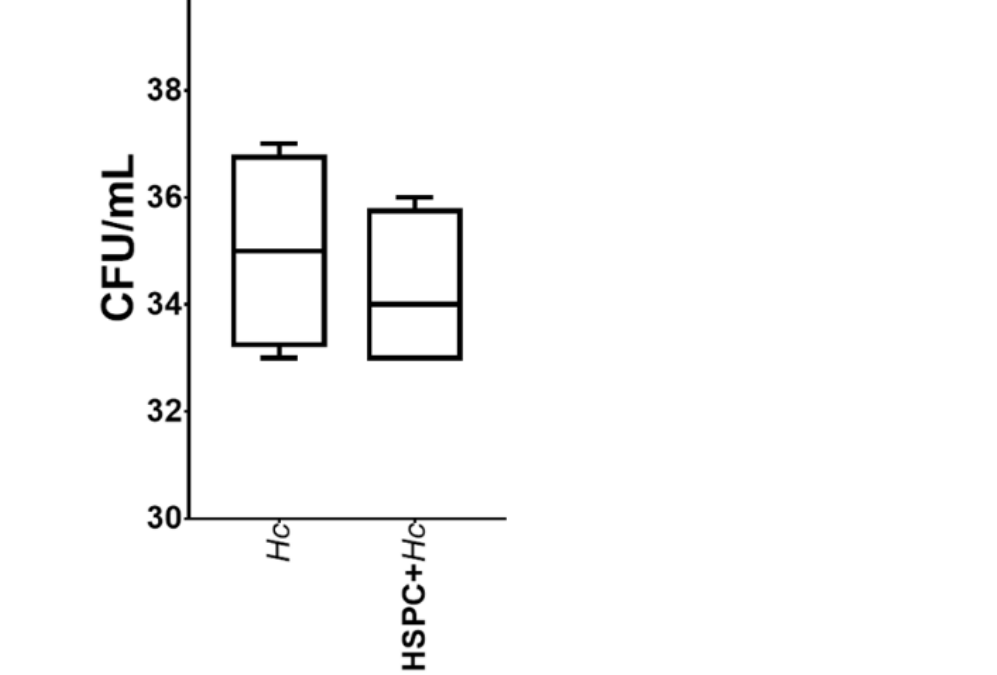
Figure 4. Fungicidal activity of HSPC against H. capsulatum . Colony forming units (CFUs) were recovered from HPSC infected with H. capsulatum yeasts after incubation for 24 h at 37 ◦ C. Results are expressed as median and IQR of pooled data from three independent